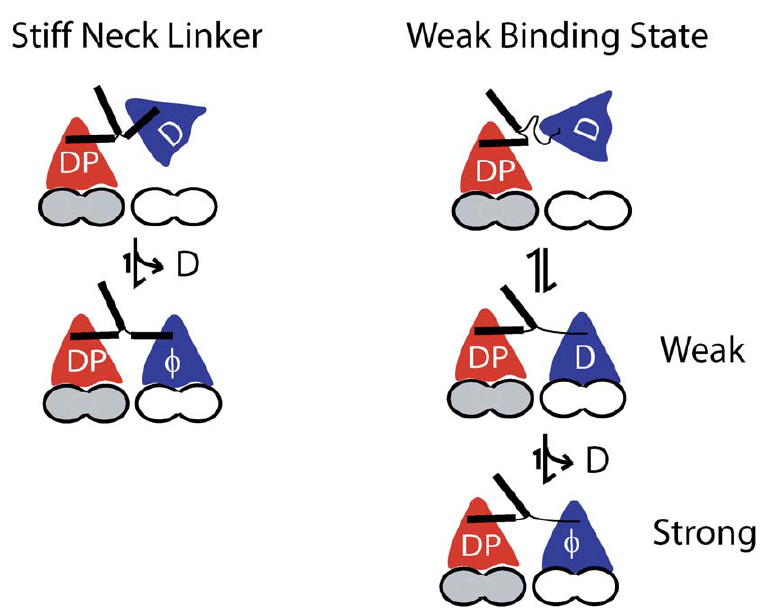
Figure 5. Possible Resolutions to the IncreasingStiffnessModel . If the neck linker is considerably stiffer than estimated from WLC models (perhaps stabilized through interactions with the core motor domain), then it would act more like a pivoting rod. Thus, the tethered head would diffuse in the vicinity of its binding site. Extending the neck linker would be expected to position the tethered head beyond its binding site, slowing the rate of attachment. Alternatively, the tethered head may be stabilized near its microtubule binding site by weak electrostatic interactions with the microtubule that counteract the restoring force of the neck linker tether. ADP release would then trigger strong binding to the microtubule.